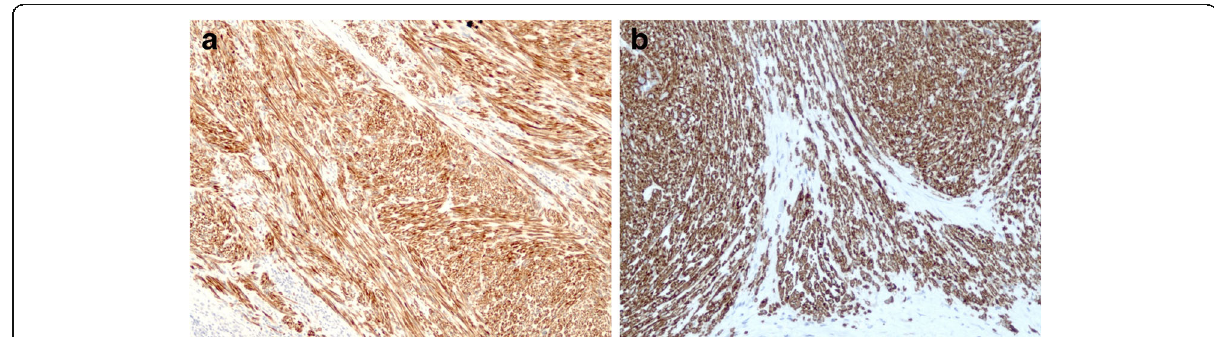
Fig. 6 On immunohistochemical staining, a desmin and α SMA and b h-caldesmon were diffusely positive, while c-kit, S100, CD34, CAM5.2, EMA, CD163, and DOG1 were